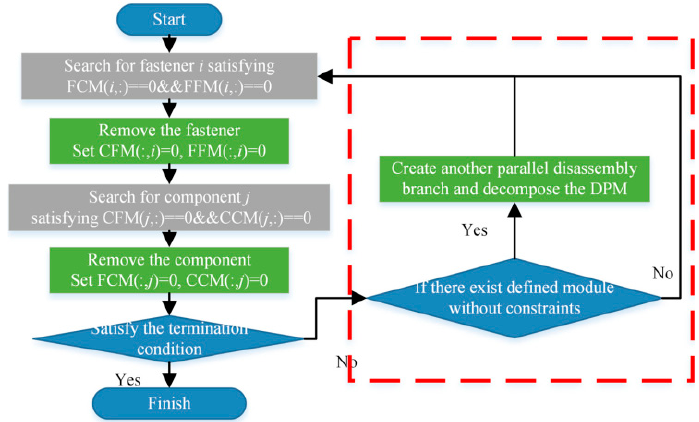
Figure 4. Flow chart for the generation of a partial/parallel disassembly sequence.